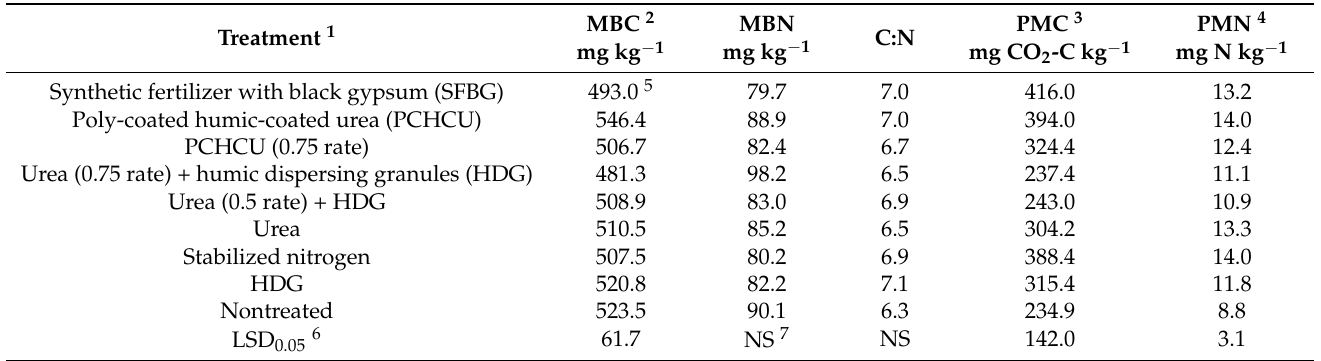
Table 6. Effects of various fertilizers on soil microbial biomass carbon (MBC), microbial biomass nitrogen (MBN), carbon to nitrogen ratio (C:N), potentially mineralizable carbon (PMC), and potentially mineralizable net nitrogen (PMN) of a native soil Kentucky bluegrass maintained at 7.6 cm in Ames, IA, USA in 2019 and